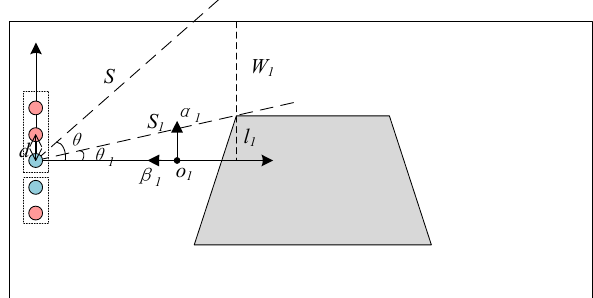
Figure 9. The impact of obstacles ahead on the UGVs fleet.